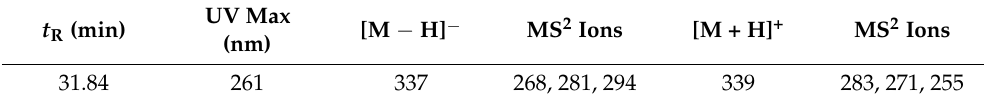
Table 1. Mass spectrometry analysis of isowighteone detected in ethyl acetate extract from the medium of elicited pigeon pea hairy root culture. Analysis was done by HPLC-PDA-electrospray ionization-MS 2 .